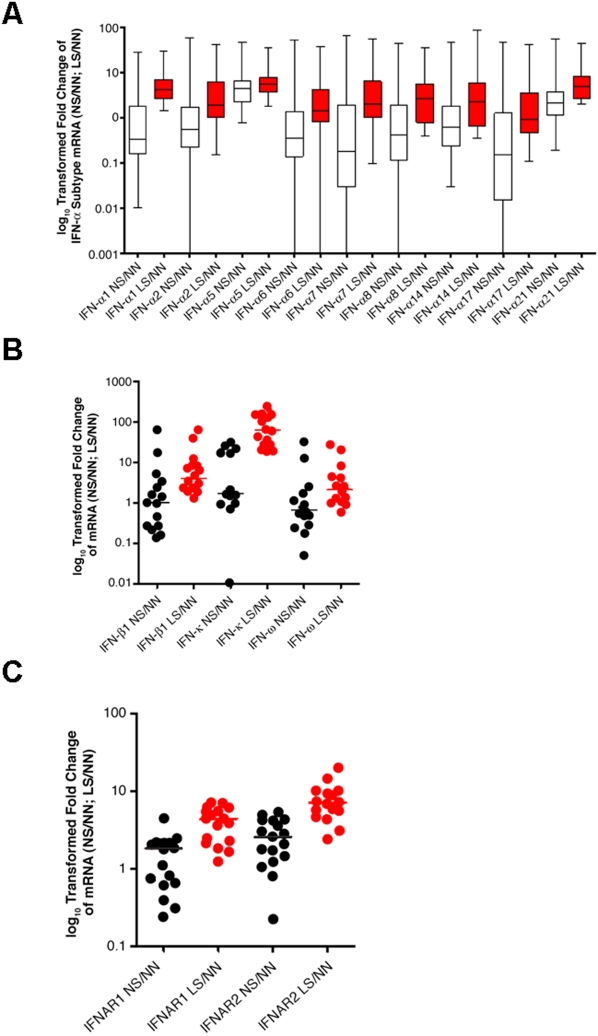
Relative expression and median fold changes of select mRNAs.Selected mRNAs include (A) Type I IFN-α subtypes (box plot), (B) other Type-I IFNs, and (C) IFN-α receptors in lesional skin (LS) or nonlesional skin (NS) compared with skin from healthy donors (NN). Horizontal bars represent median fold change. Black points: relative fold change in NS vs NN (NS/NN); Red points: relative fold change in LS vs NN (LS/NN). The P values for the overexpression of these genes in NS or LS vs NN (listed in pairs) are as follows: IFN-α1, 0.303, <0.001; IFN-α2, 0.389, 0.072; IFN-α5, <0.001, 0.002; IFN-α6, 0.664, 0.093; IFN-α7, 0.586, 0.077; IFN-α8, 0.430, 0.049; IFN-α14, 0.224, 0.049; IFN-α17, 0.552, 0.0203; IFN-α21, 0.113, 0.003; IFN-β, 0.255, 0.022; IFN-κ, 0.03, <0.001; IFN-ω, 0.516, 0.049; IFNAR1, 0.192, <0.001; IFNAR2, <0.001, <0.001, respectively.